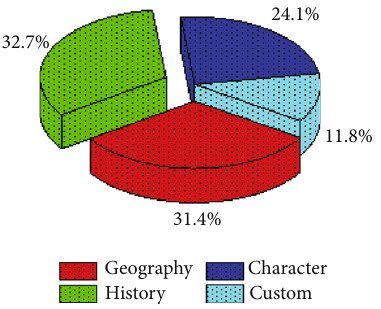
Figure 7: The key points of Korean envoys focus on.